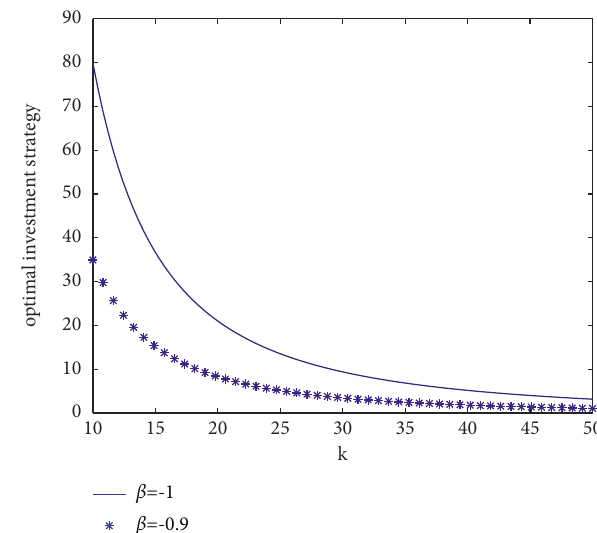
Figure 4: Influence of k on optimal investment ratio π ∗ t .